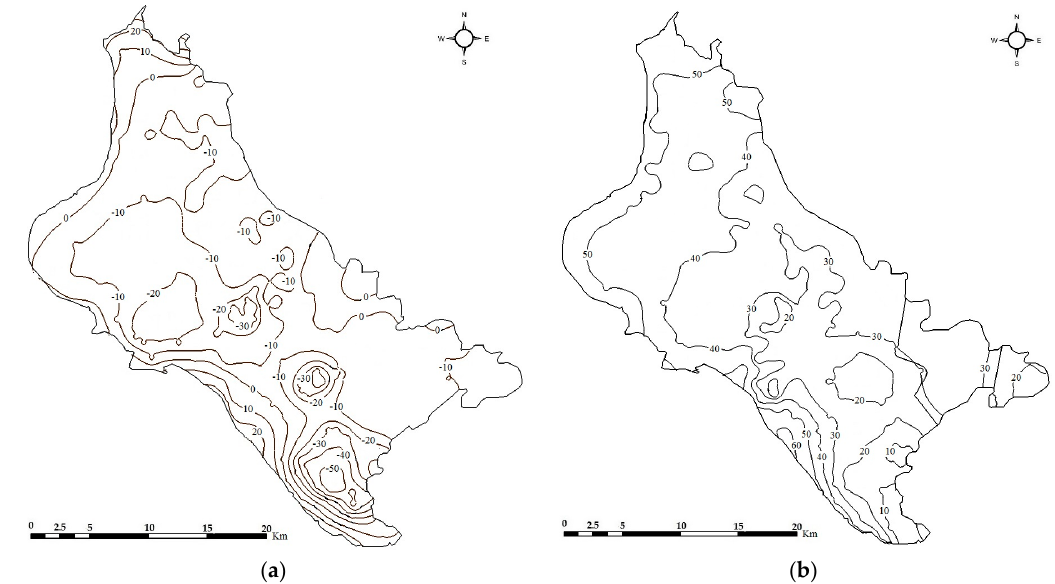
Figure 4 . The hydraulics heads on the operational scenarios. ( a ) Presents the hydraulic heads at the first operational scenarios and ( b ) indicates the hydraulic heads at the second operational